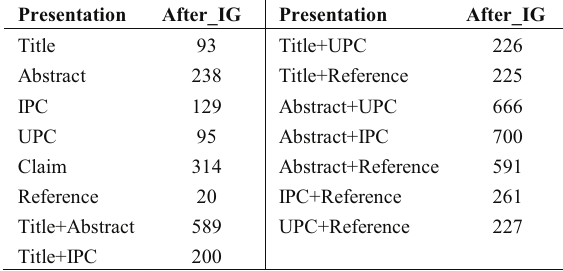
Table 2. Attribute number after feature selection with IG.